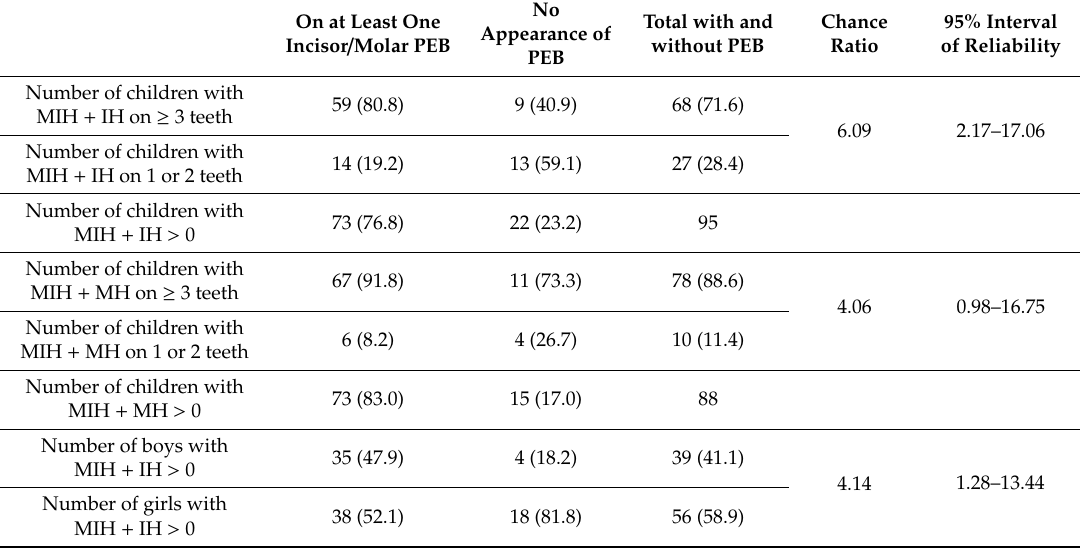
Table 6. Posteruptive damage of enamel (PEB) and opacities linked to the number of a ff ected permanent teeth classified by